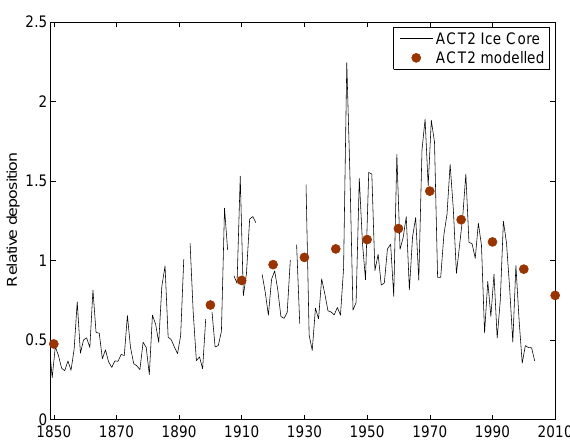
Fig. 11. Modelled relative deposition of sulphur (red dots) and rela- tive deposition of sulphur from ACT2 ice core (solid line) in Green- Figure 11: Modelled relative deposition of sulphur (red dots) and relative depo- land (McConnell and Edwards et al., 2008). The annual depositions sition of sulphur from ACT2 ice core (solid line) in Greenland (McConnell and are plotted relative to the mean deposition between 1900 and Edwards et al. 2008). The annual depositions are plotted relative to the mean deposition between 1900 and 2000.